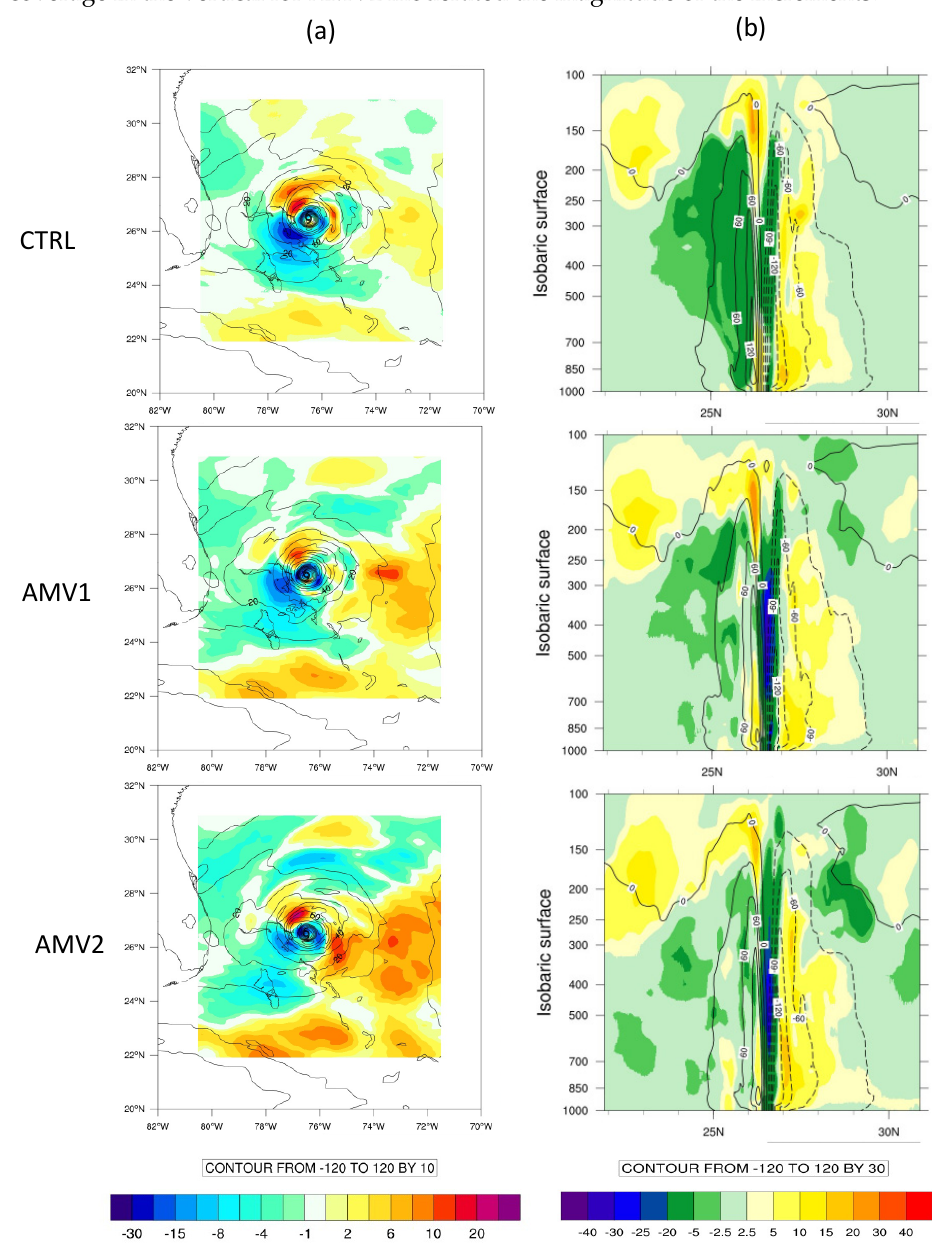
Figure 8. First guess wind speed (kts) in black contours and u-component wind (kts) analysis increment (analysis—first guess) in color shades. ( a ) 250 hPa isobaric level. ( b ) Meridional cross section of the inner core domain taken through the center of the storm (marked with an “x”) defined by the NHC best track at 26.5 oN, 76.5 oW for Hurricane Dorian at 12 UTC on 1 September 2019 for (top) CTRL, (center) AMV1 and (bottom) AMV2.